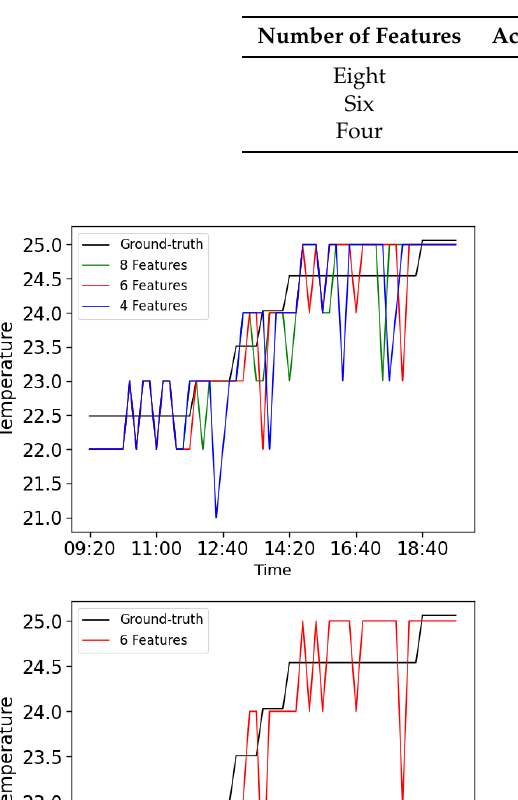
Table 2. The results of forecasting temperature in dynamic settings.